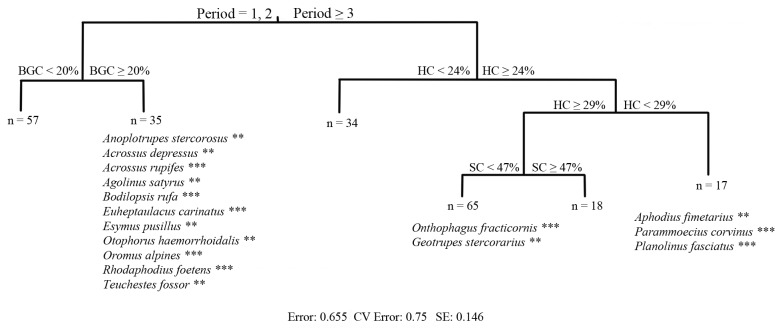
Multivariate Regression Trees and associated Indicator Value analyses.MRT for dung beetle abundance within TNCA one year after treatment. Numbers below each branch end give the number of traps. Only species which are significantly associated with one of the branches are shown. Statistical significance was obtained by Monte Carlo randomization tests (1000 runs). The model has an error term = 0.655 and crossvalidated error = 0.75 (0.146 SE). Period, BGC, HC, and SC represent the dung beetle sampling period, the percentage of bare ground cover, the herbaceous layer cover, and the shrub layer cover, respectively.